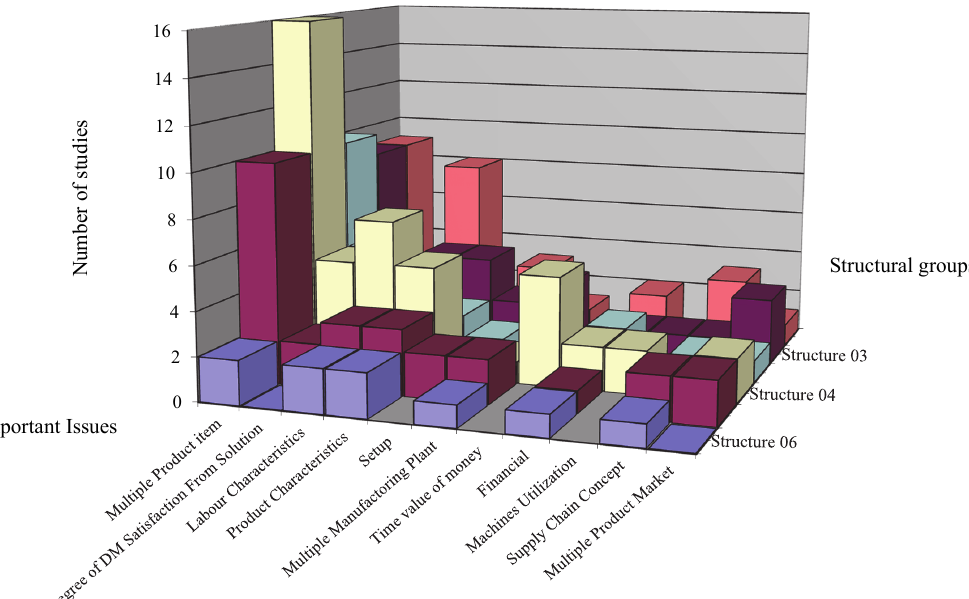
Fig. 2. Number of studies associated with important issues used in structural